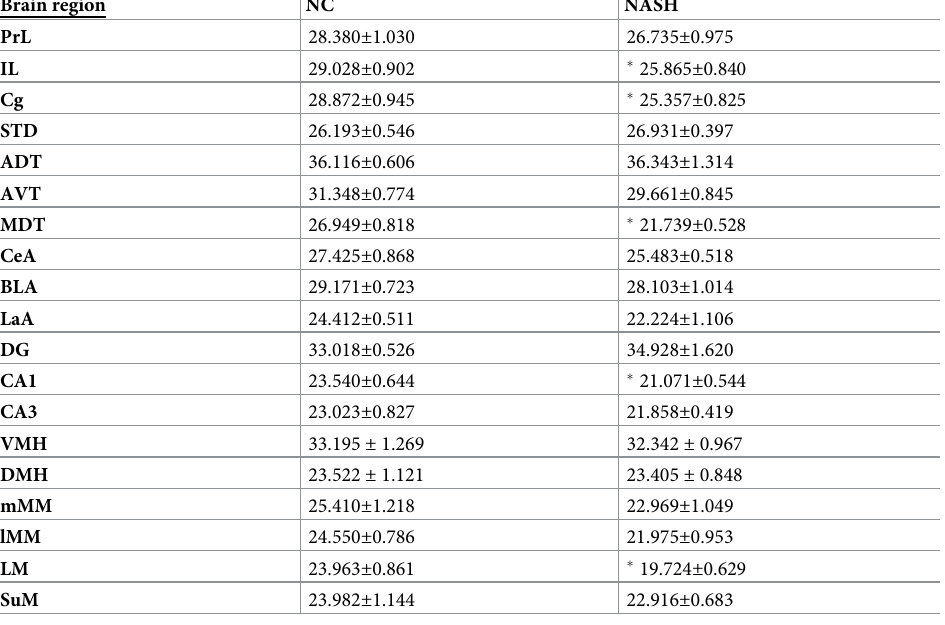
Table 4. Metabolic brain